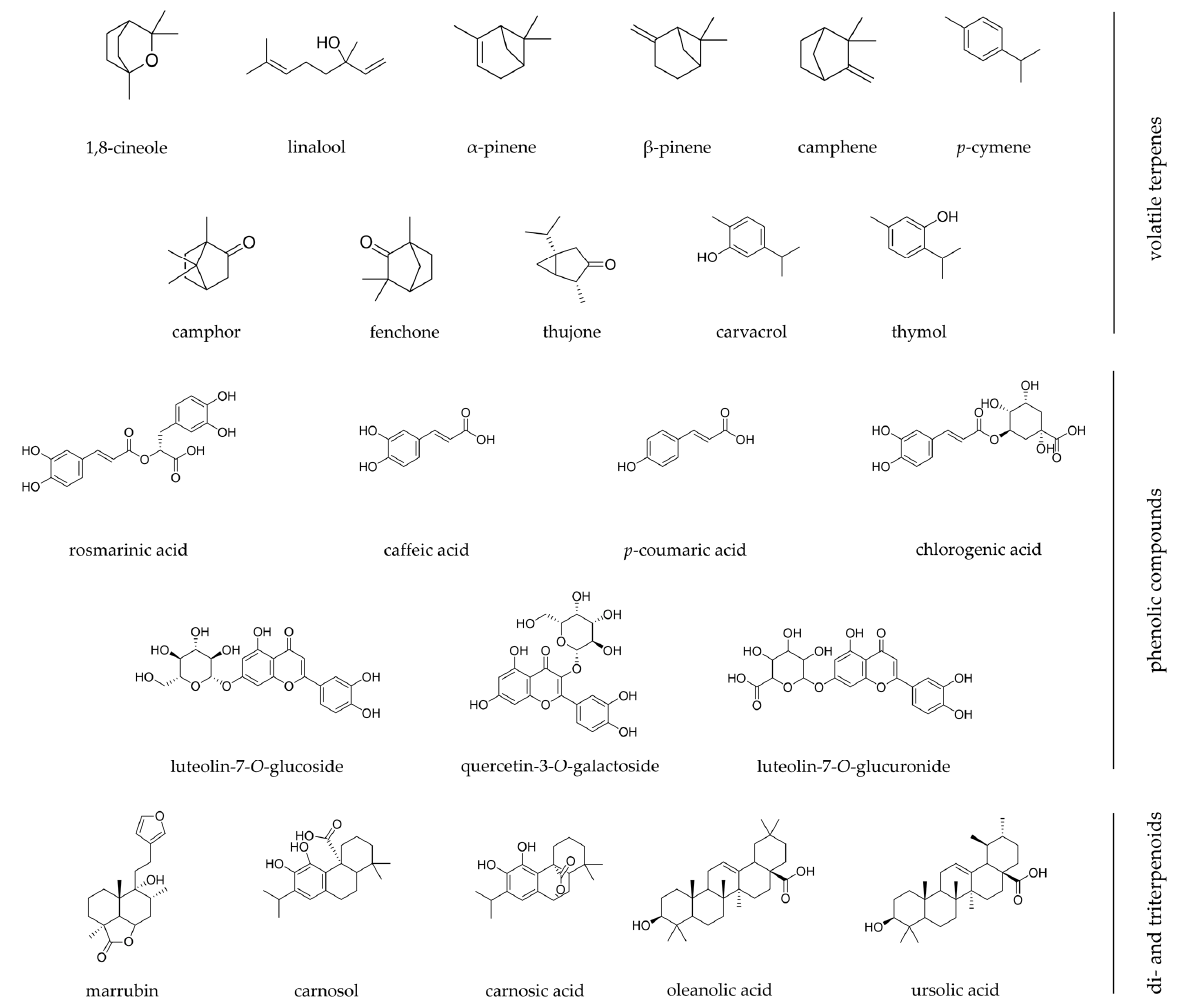
Figure 2. Chemical structures of the most relevant phytochemicals found among Iberian Lamiaceae species with wound healing scientific validation. Chemical structures were designed using ChemDraw software. Table 2. Clinical trials using Iberian Lamiaceae species with wound healing activity.